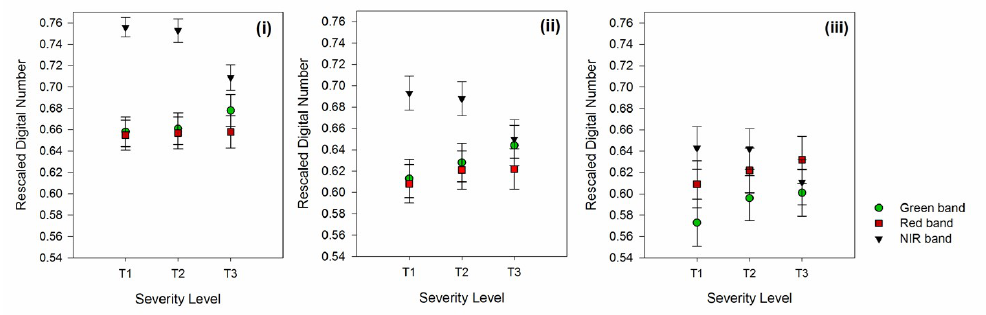
Figure 3. The mean and standard deviation of rescaled DN for circle radius of ( i ) 25, ( ii ) 35, and ( iii ) 45 pixels in the three bands, tested for the 1/8 threshold